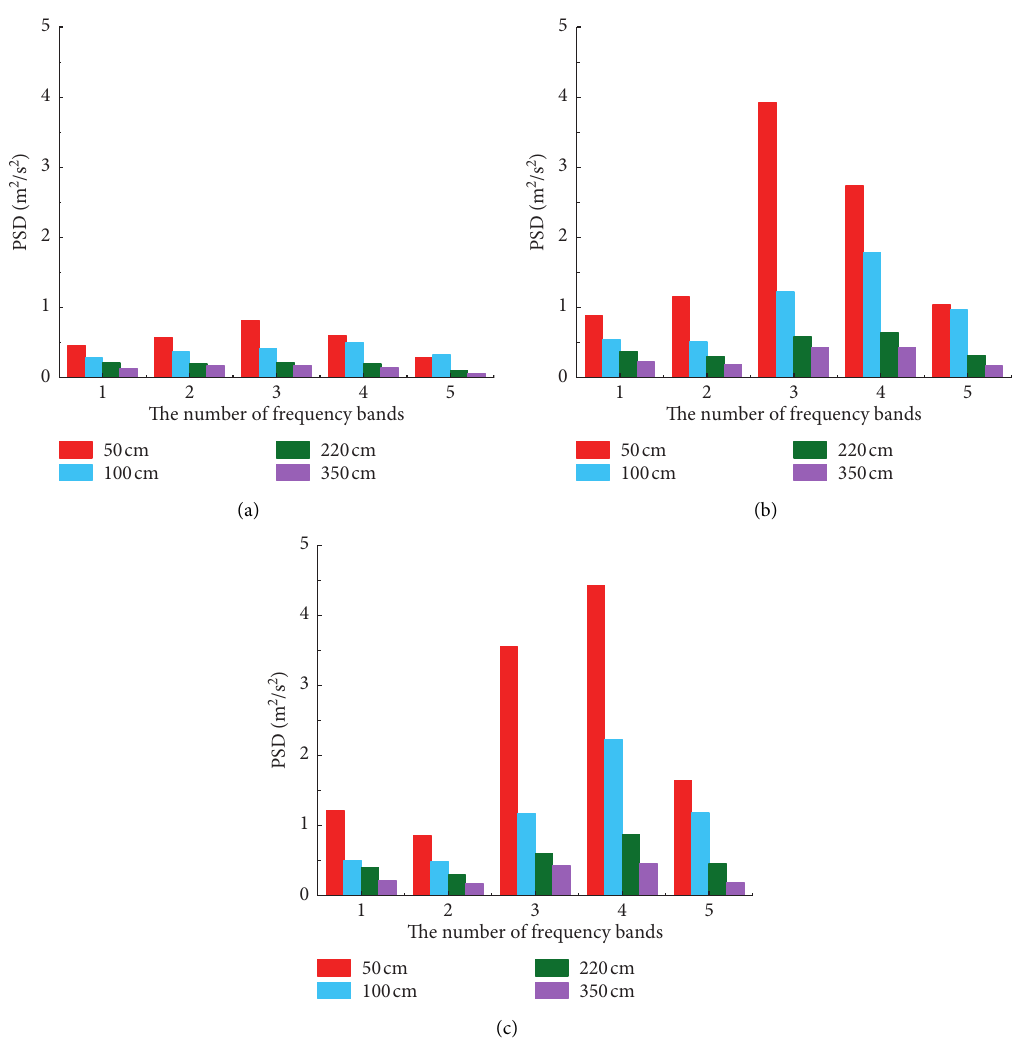
Figure 12: Distribution diagram of the frequency division vibration energy of the test section at various vehicle speeds: (a) v � 20km/h, (b) v � 40km/h, and (c) v � 60